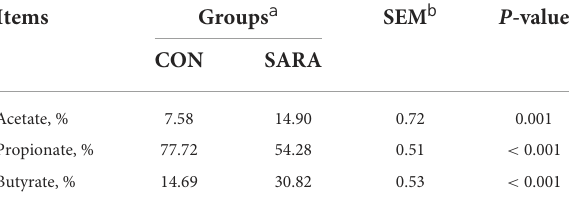
FIGURE5 The dynamic variation of lactate clearance rate in the rumen fluid of goats under normal (CON) or SARA condition. Data were